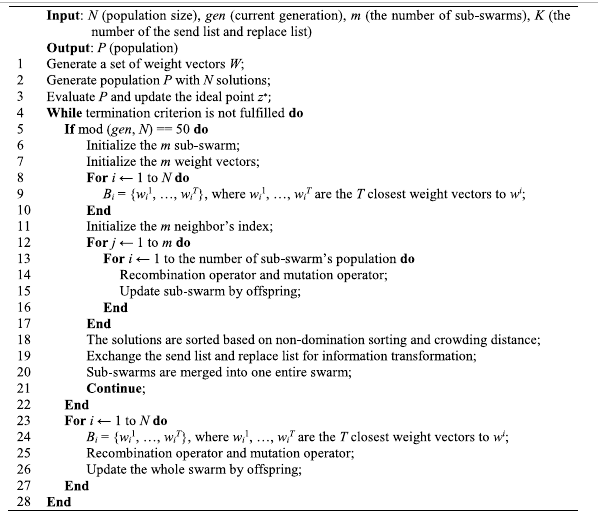
TABLE 1 | General steps of the MSMOEA/D algorithm.